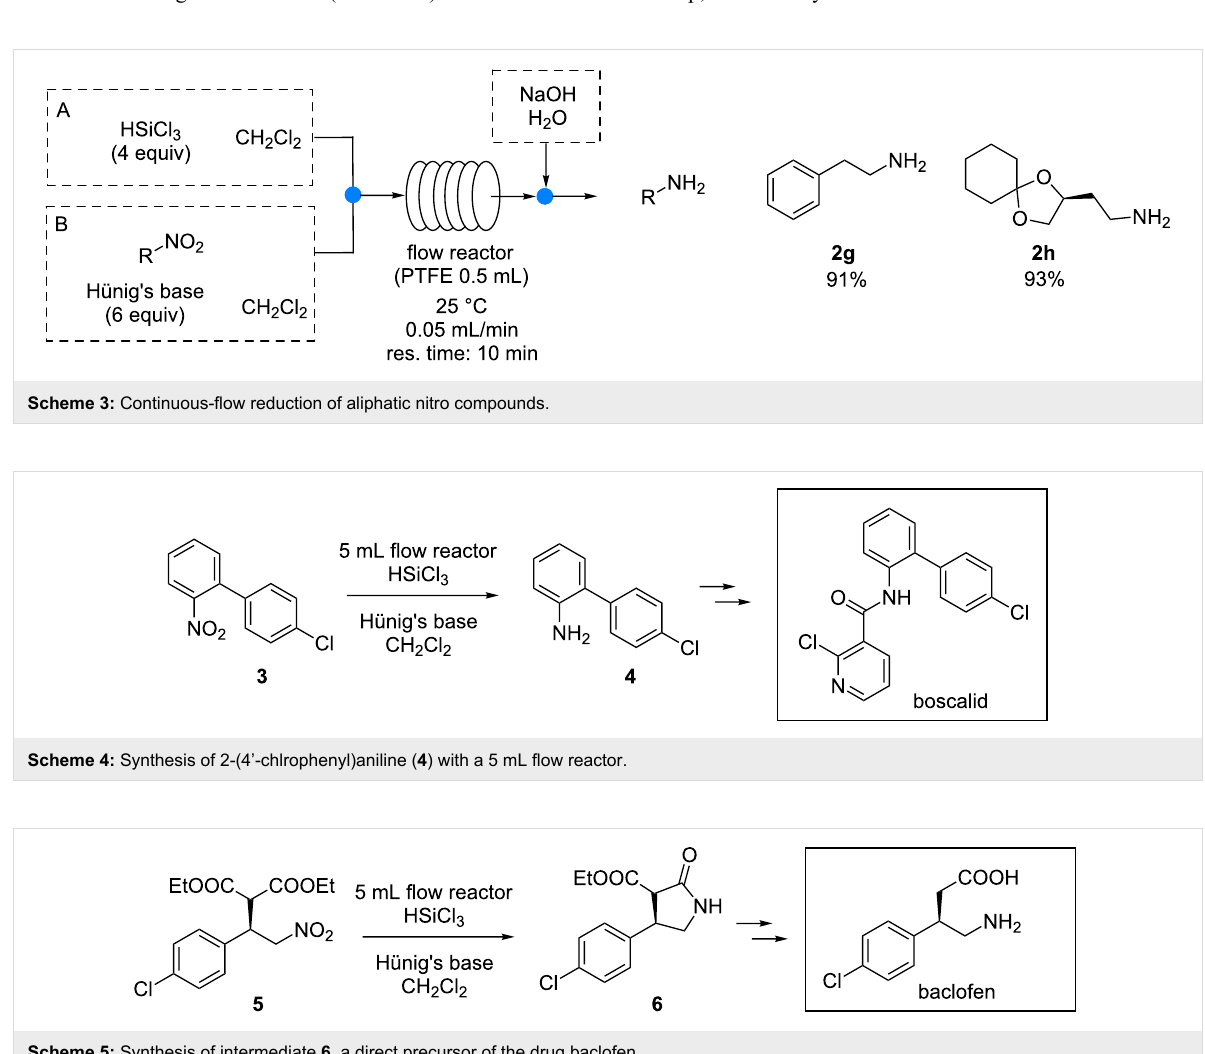
Scheme 5: Synthesis of intermediate 6 , a direct precursor of the drug